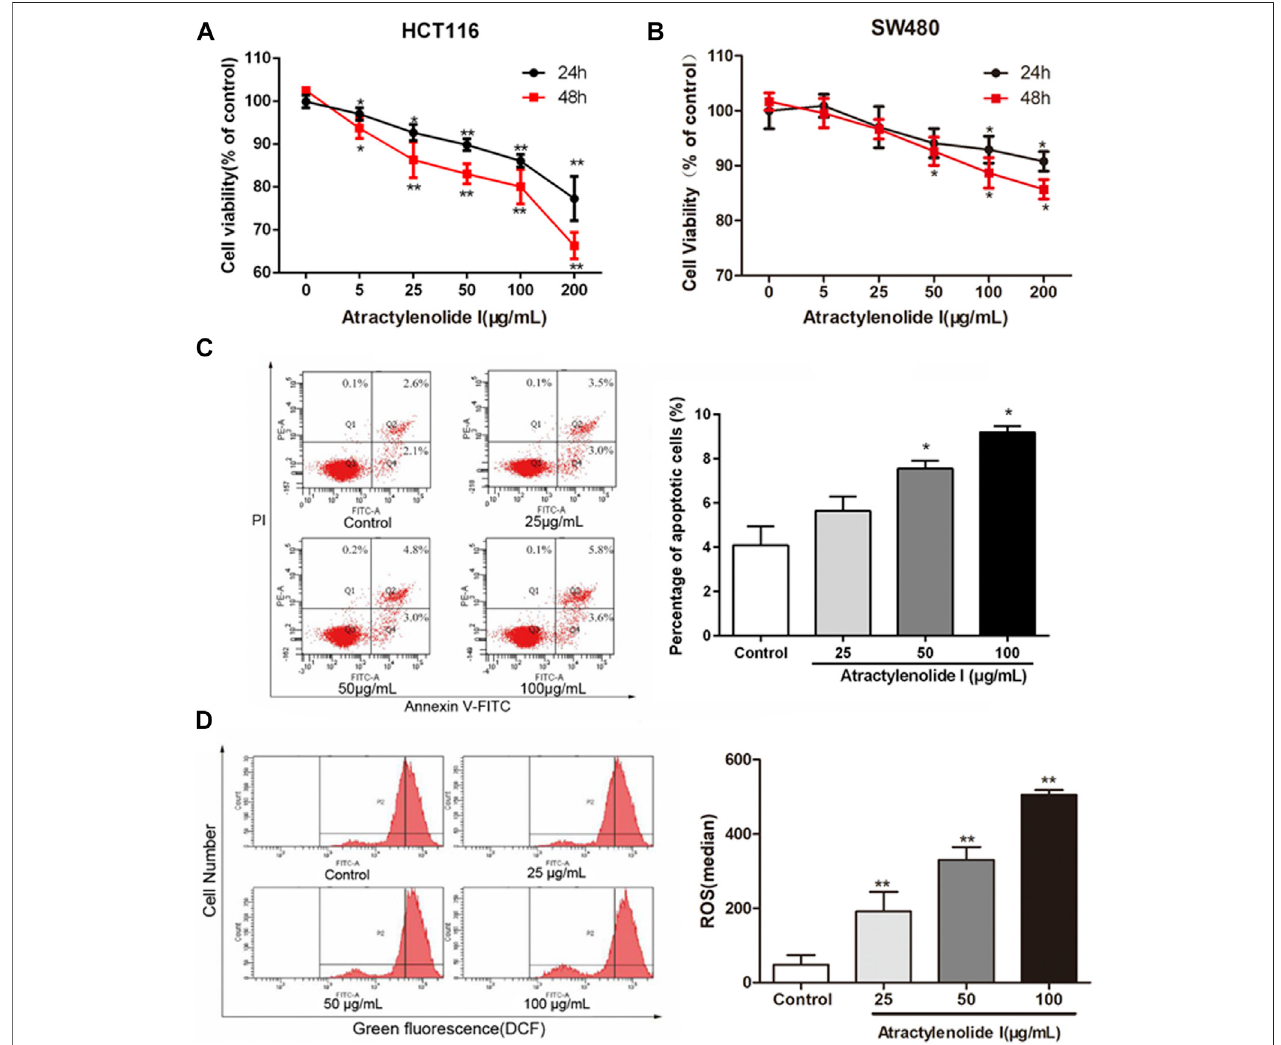
FIGURE 1 | Atractylenolide I signi fi cantly inhibit cell viability via apoptosis to a certain extent in CRC cells. (A) Cell viability treated with different concentrations of atractylenolideIwasmeasured bytheCCK-8assayat24and48 handplottedasadose – responsecurverelativetono-drugcontrols( n (cid:2) 6pergroup). (B) SW480cells treatedwiththe atractylenolideI(n (cid:2) 6 per group). (C) Measurement of PE-Annexin Vstainingofphosphatidylserineexposed on the cell surface by fl ow cytometry (n (cid:2) 3 per group). (D) The ROS levels in HCT-116 cells treated with atractylenolide I (25, 50, and 100 μ g/ml) by loading DCFH-DA fl uorescent probes (n (cid:2) 3 per